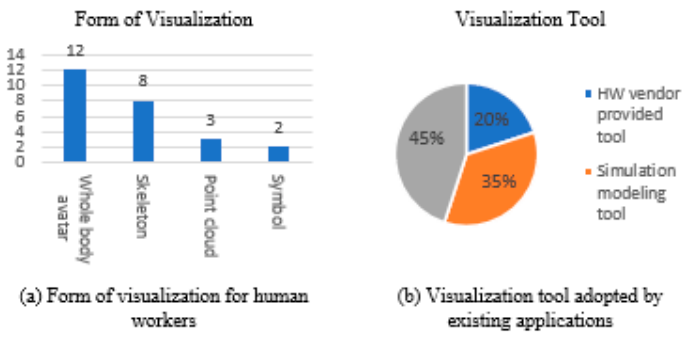
Figure 10. Visual representation of existing applications